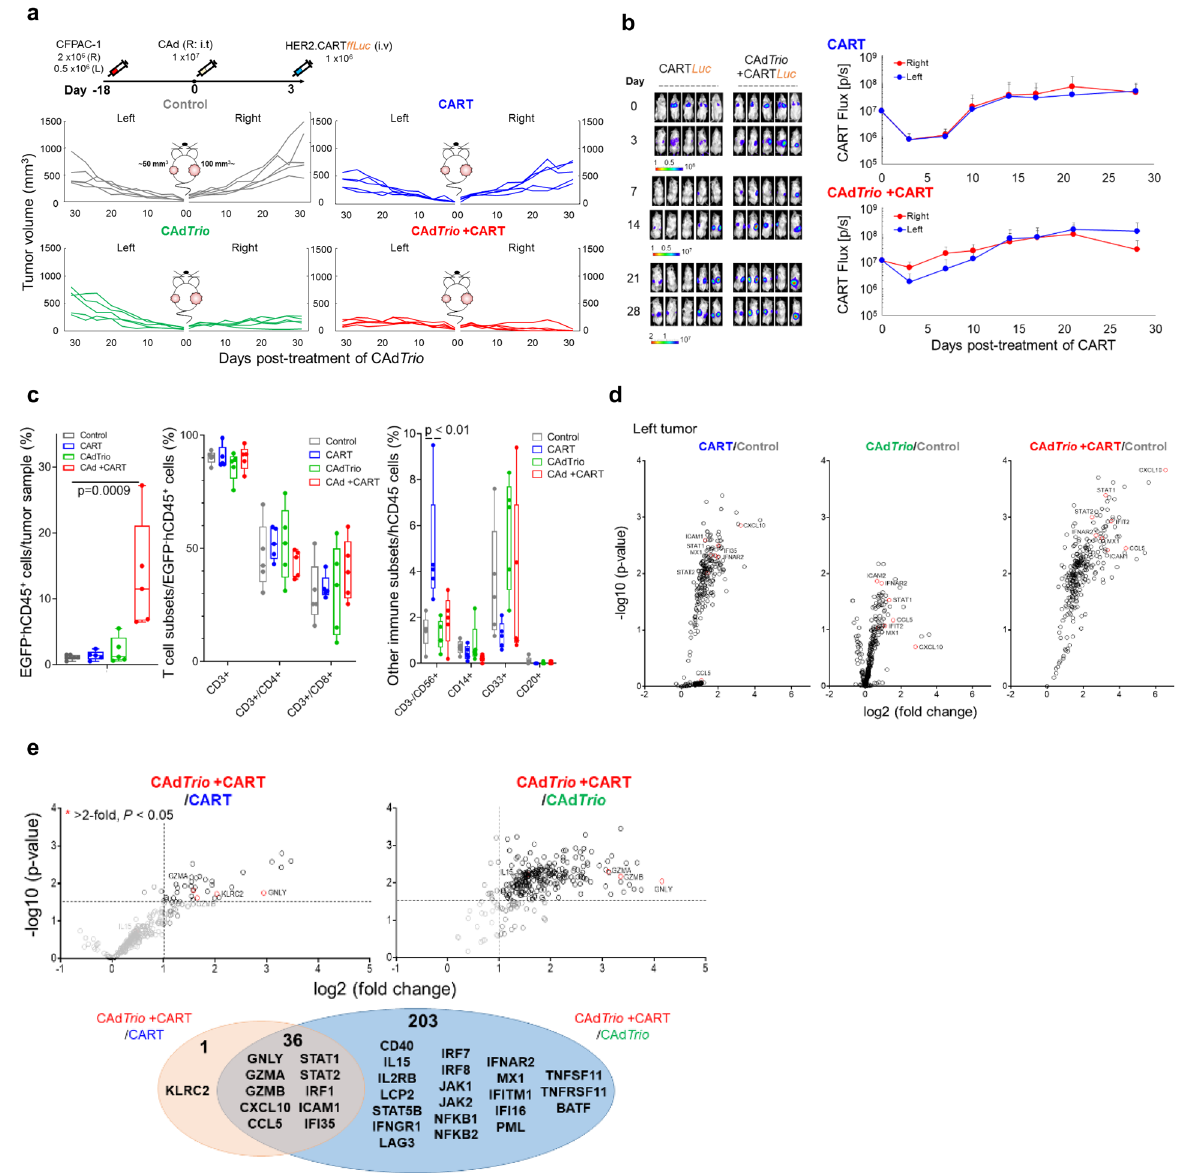
Fig. 5 Combination immunotherapy controls tumor growth in humanized mice with multiple PDAC tumors. a CFPAC-1 cells were transplanted into the right and left fl anks of humanized mice ( n = 5 animals). A total of 1 × 10 7 vp of CAd Trio (OAd:HD = 1:1) were injected into the right tumor. A total of 1 × 10 6 HER2.CARTs expressing ffLuc were systemically administered 3 days post injection of CAd Trio . Tumor volumes were monitored at different time points. b Bioluminescence of HER2.CARTs was monitored at different time points. Data are presented as means ± SD. c CFPAC-1 tumors were harvested from humanized mice at 31 days post injection of CAd Trio , and tumor in fi ltrating human immune cells were analyzed by fl ow cytometry. Box plot elements: central line, median; box limit, upper and lower quartiles; whisker, 1.5x inter-quartile range; points, outliers. P -values were determined using ordinary one- way ANOVA with Tukey multiple comparisons, p = 0.0009 (F(3,16) = 9.252), p < 0.01 (F(3,16) = 6.426). Statistical signi fi cance set at p < 0.05, ns > 0.05. Total RNA was extracted from whole tumor at 31 days post injection of CAd Trio . Gene expression was pro fi led with Nanostring, differential gene expression compared to control tumors ( d ) and compared to single agents ( e ) are shown. Abbreviations: s.c. subcutaneous, i.t. intratumoral, i.v.